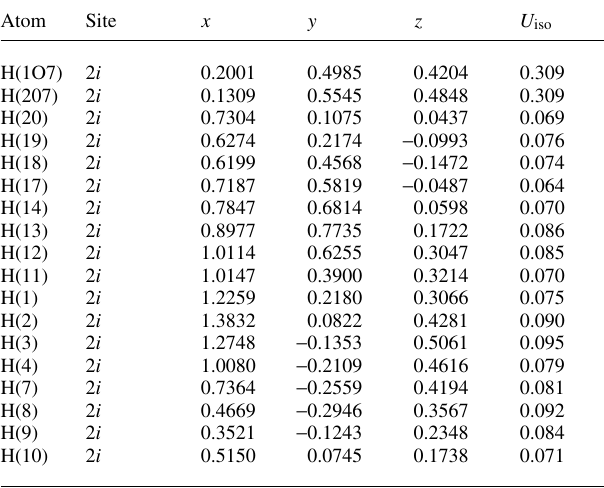
Table 2. Atomic coordinates and displacement parameters (in Å 2 )